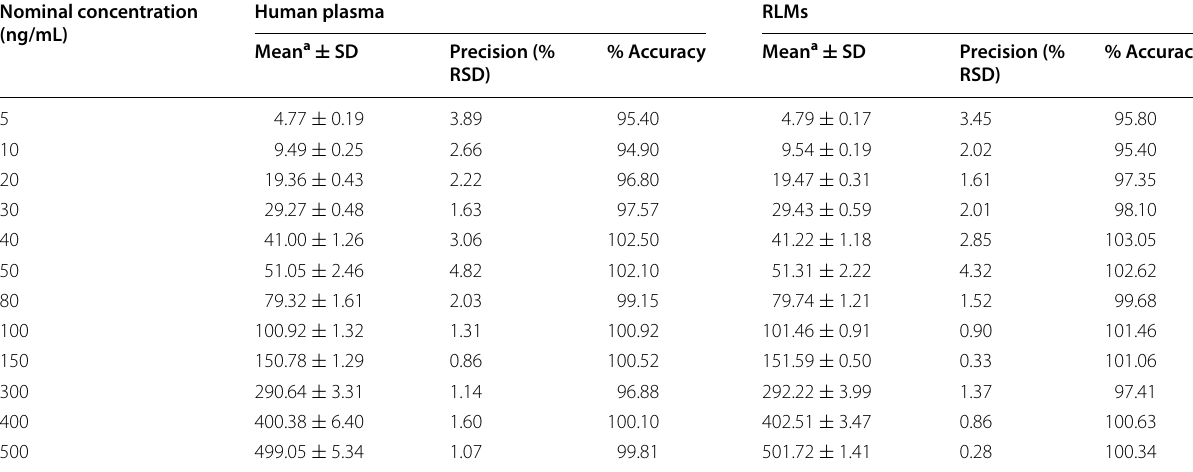
a Average of six determinations